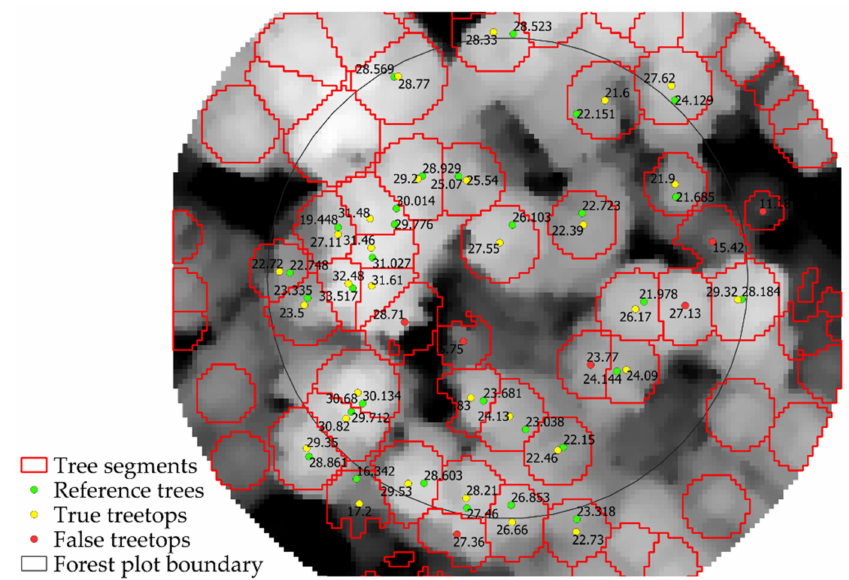
Figure 4. Tree segments with detected